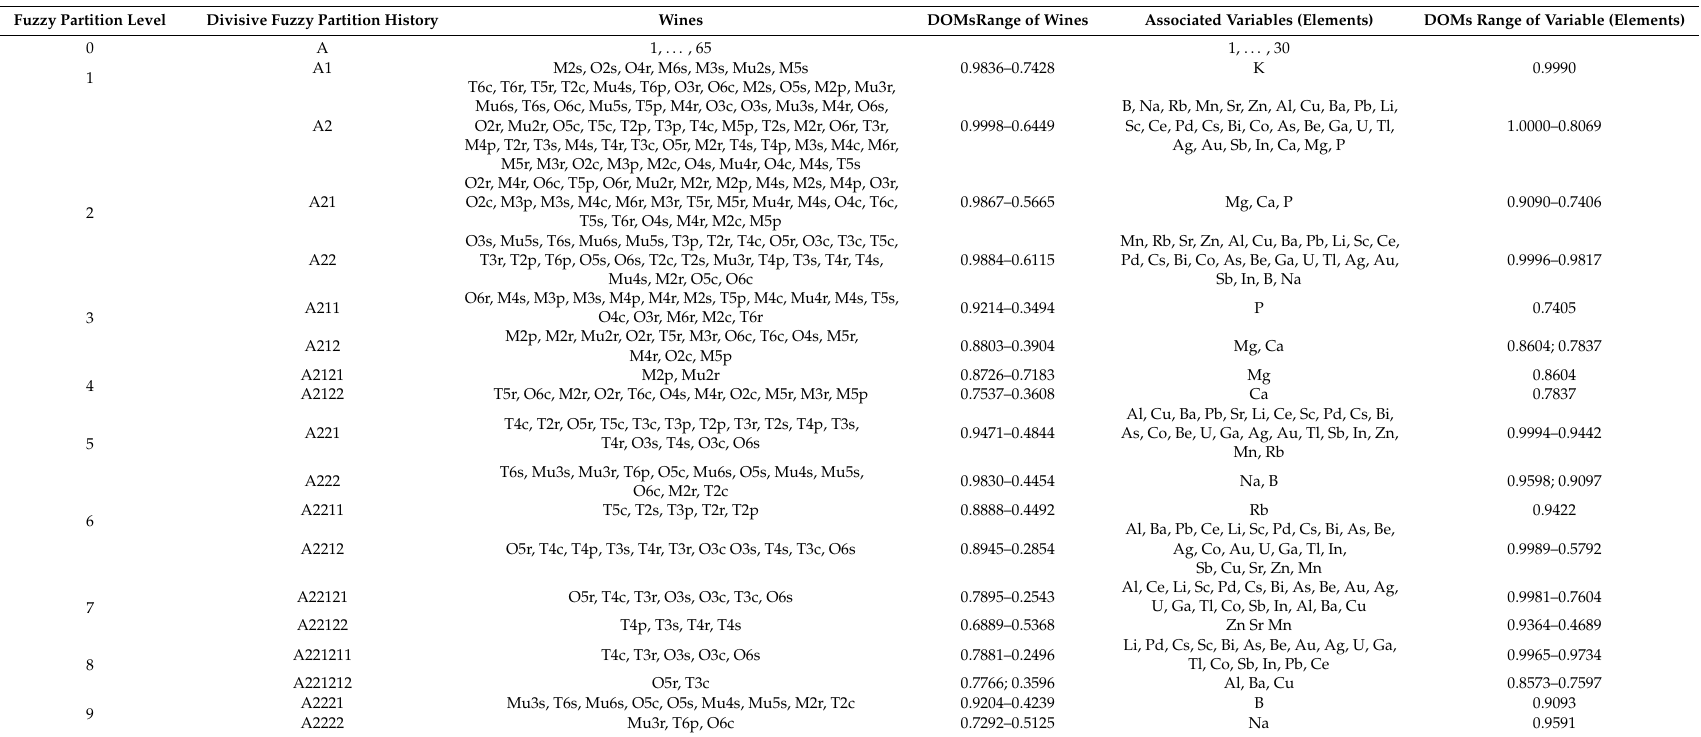
Table 2. The fuzzy divisive hierarchical associative-clustering partitions of wines and variables (wines and chemical elements are arranged in decreasing order of